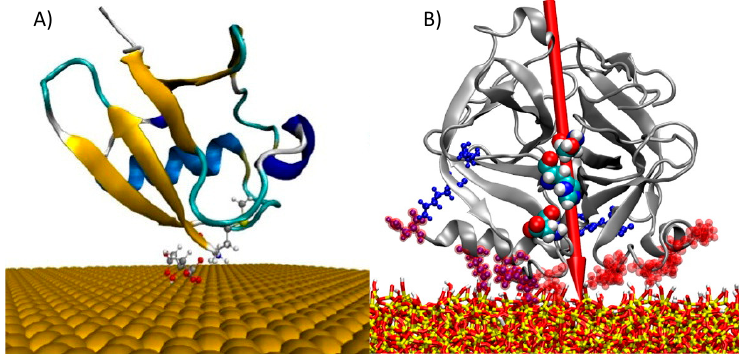
Figure 4. Modeling of proteins on di ff erent surfaces ( a ) ab initio Quantum Mechanics (QM), Molecular Dynamics (MD) and Brownian dynamics is used to study Ubiquitin-Au complex [75]. ( b ) The adsorption of α -chymotrypsin and hen egg white lysozyme on amorphous silica is studied by means of MD simulations in comparison with adsorption experiments. [76] .